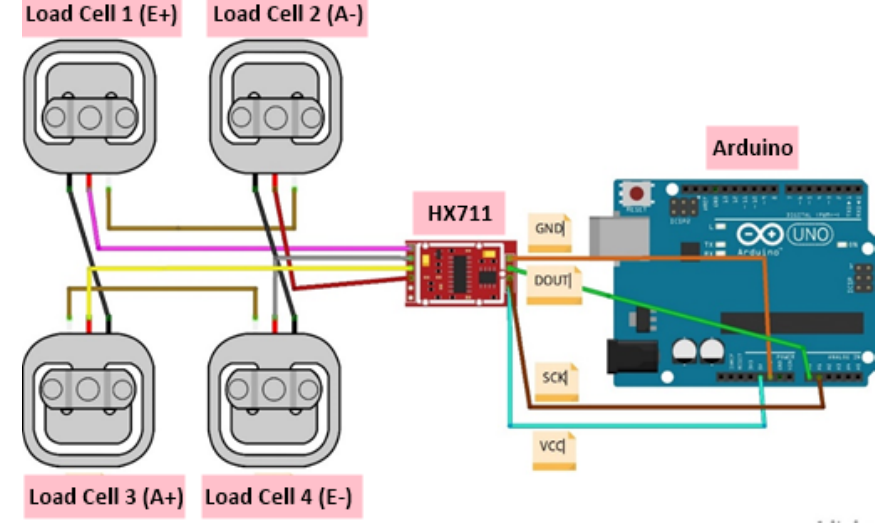
Figure 3. Load cell sensor communication circuit and HX711 module with Arduino.